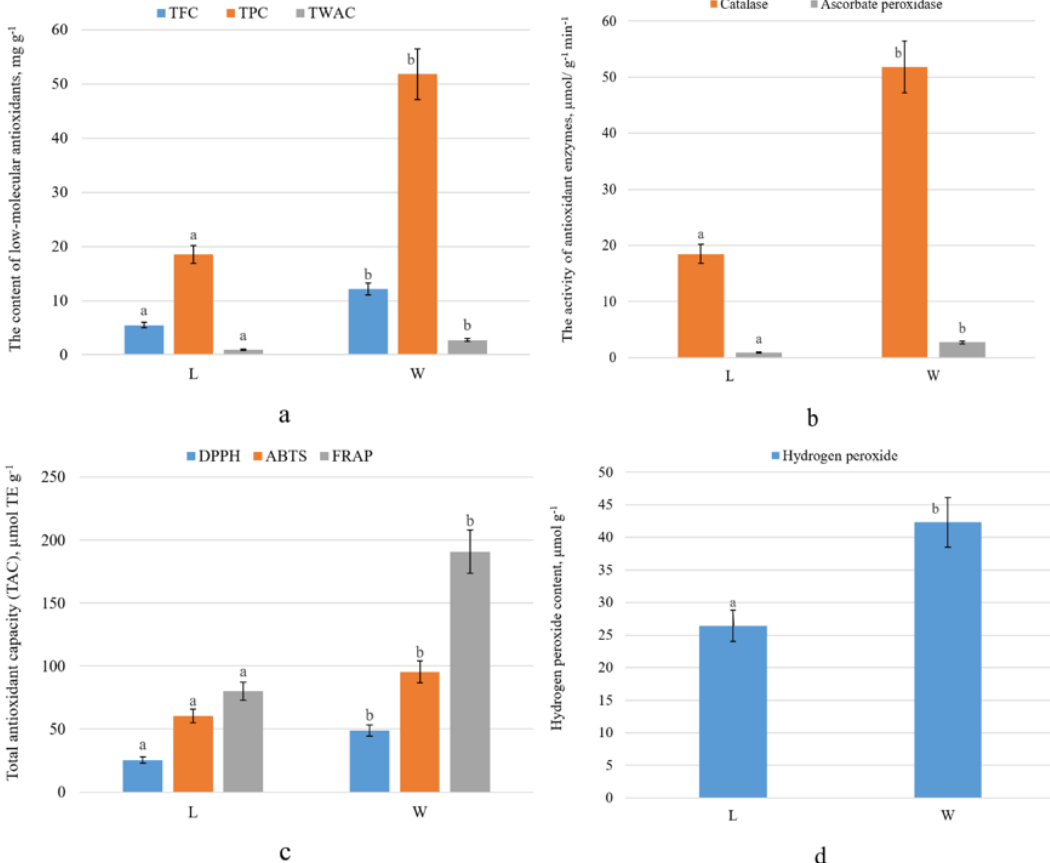
Figure 7. ( a ) Content of low-molecular antioxidants, ( b ) the activity antioxidant enzymes, ( c ) total antioxidant capacity and ( d ) the content of hydrogen peroxide in the leaves of beach pea on the windward (W) and leeward sides (L) of the foredune (July 2018). Data expressed as mean values ± standard deviations, ( n = 45). Differences were considered significant at p ≤ 0.05. Letters indicate statistical difference; means with different letters considered statistically different (Student’s t- test, p < 0.05).